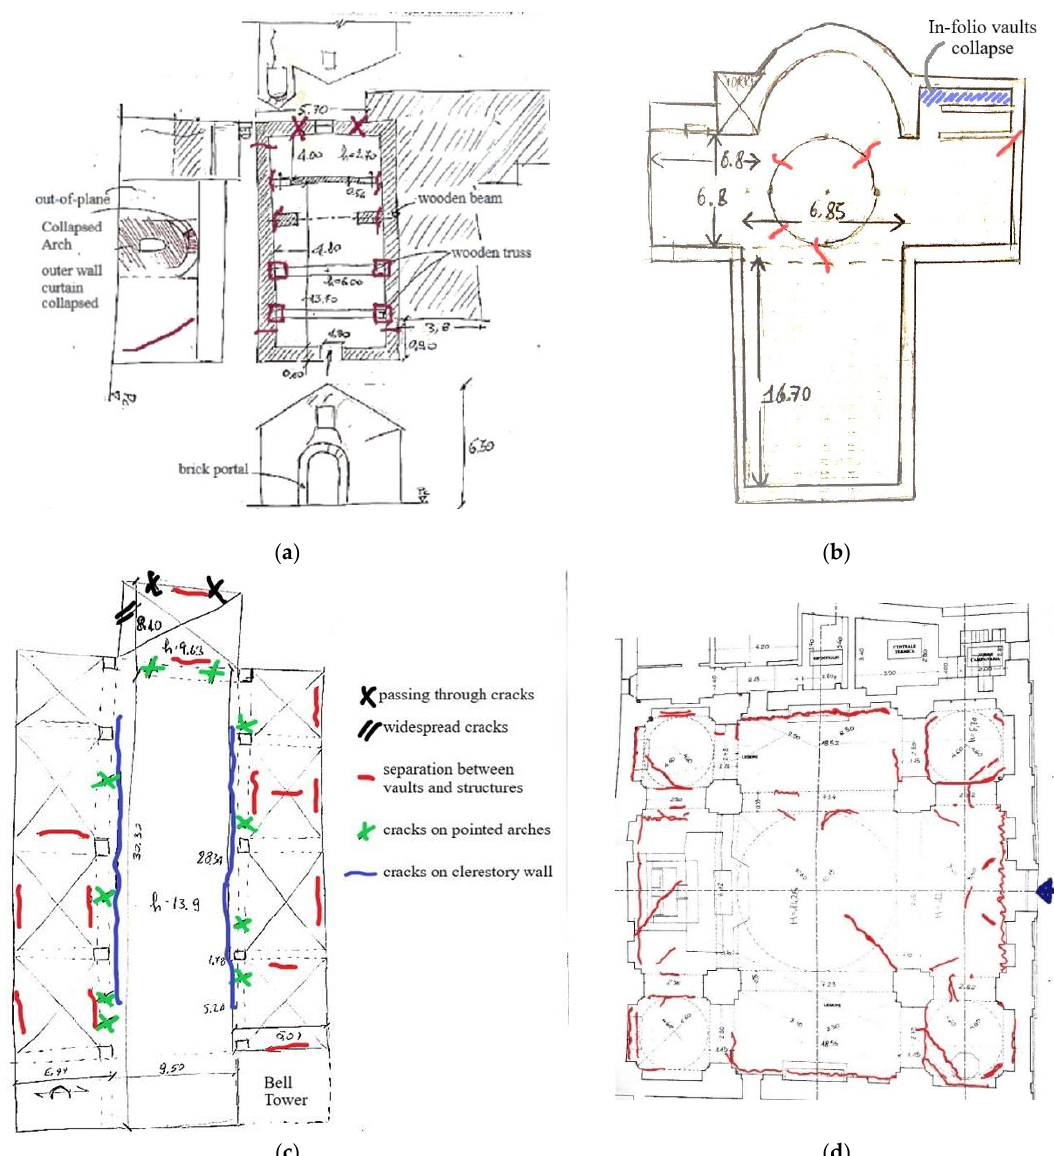
Figure 4. Plan configuration with observed crack patterns of some inspected churches: sketches made during the inspections. ( a ) Single nave (SN) typology: the church of Saint Elpidio in Campli. ( b ) One nave with transept (SNT): St. Lowrance in Civitella del Tronto. ( c ) Three naves and transept (3NT): the Dome of Campli, Holy Mary in Platea. ( d ) Central plan configuration (C): the church of Saint Savino in Gualdo.